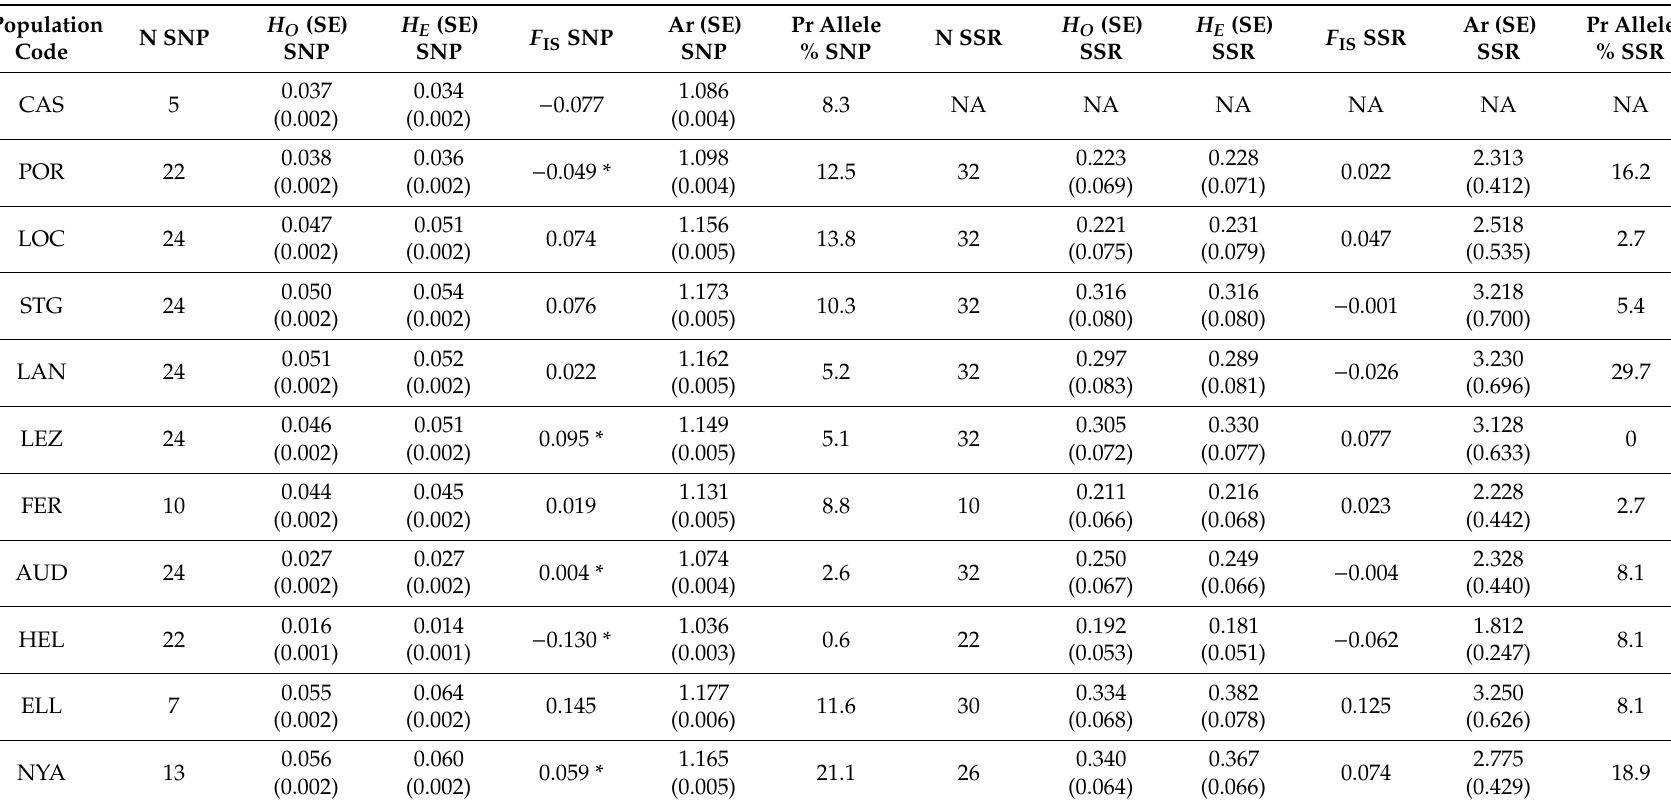
Table 1. Within-locality genetic diversity indices for 11 Saccharina latissima localities genotyped with single nucleotide polymorphisms (SNPs) and 10 localities genotyped with genomic and ESTderived microsatellites (SSRs). N—number of genotyped samples, H O —observed heterozygosity, H E —expected heterozygosity, F IS —inbreeding coe ffi cient (significant values ( p -value < 0.05) marked with *), Ar—allelic richness (for the SNPs the alleles were rarefied down to ten alleles and for the SSRs the alleles were rarefied down to 44 alleles), and Pr Allele %—percentage of the total number of private alleles (total of 2337 private alleles for SNPs, and 37 private alleles for SSRs). SE—standard error. NA—the analyses were not performed. CAS—Castelo do Neiva, POR—Portiño de Dexo,